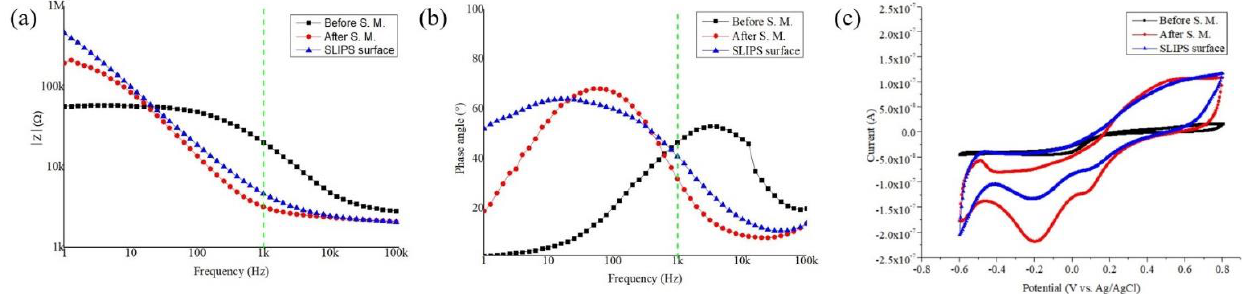
Figure 6. Electrochemical performance of the proposed electrode before the surface modification, after the surface modification by Pt-gray, and SLIPS coating. ( a ) Electrochemical impedance profile, ( b ) phase angle profile, and ( c ) CV analysis at a sweep rate of 50 mV/s. Table 1. Comparison of reduction in impedance at 1 kHz and CSC of the proposed ECoG electrode for various sample